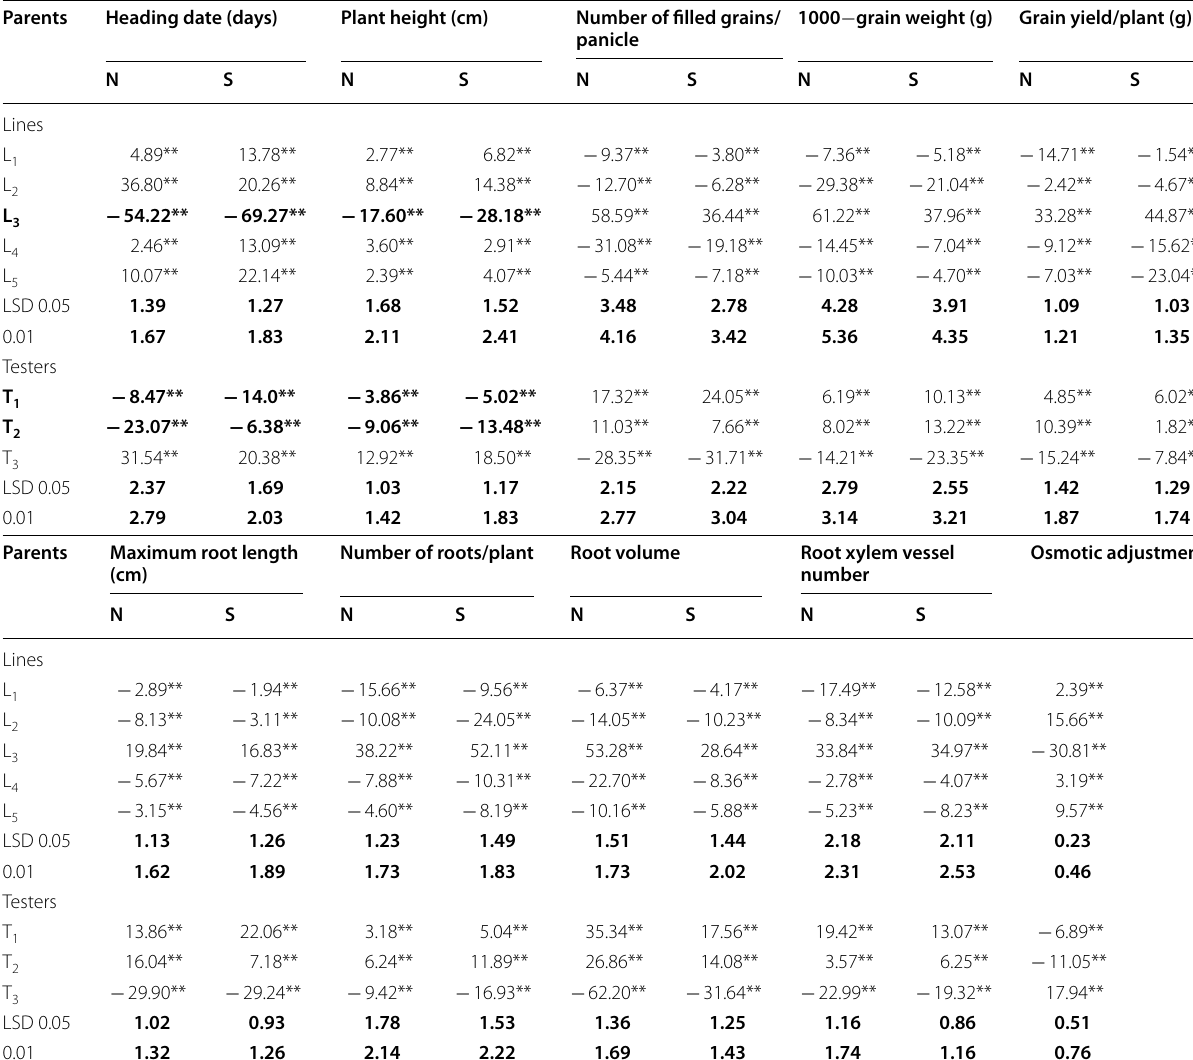
Table 5 Evaluated of GCA effects in eight rice parents of all studied traits for the two experiments of normal and drought stress